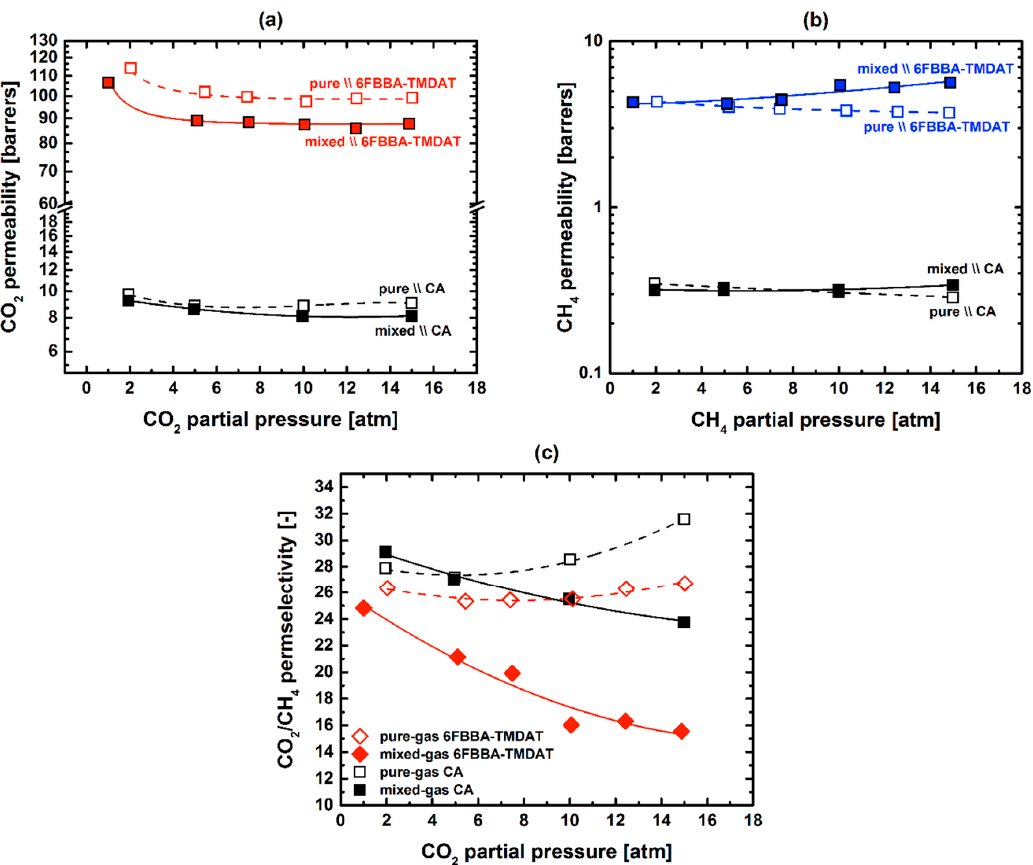
Figure 11. Experimental ( a ) CO 2 and ( b ) CH 4 pure- and mixed-gas permeability vs. partial gas pressure for 6FBBA-TMDAT polyamide and CA [64]. ( c ) pure- and mixed-gas CO 2 /CH 4 permselectivity of the same polymers. Lines are drawn to guide the eye.